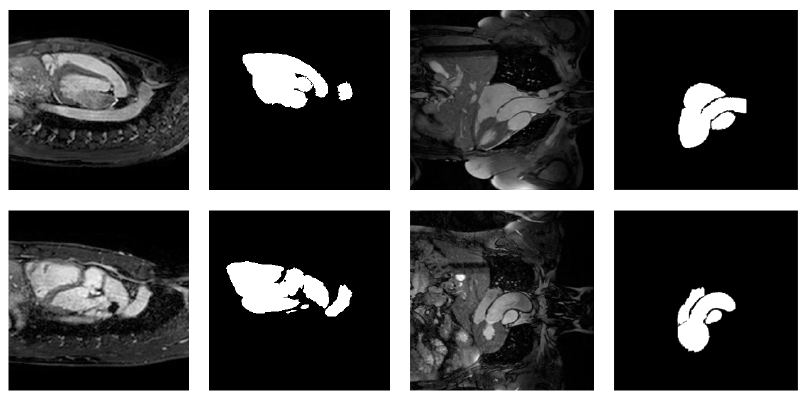
Figure 1. Samples from the MMWHS dataset showing four cardiac MRI images along with the manual segmentation of the